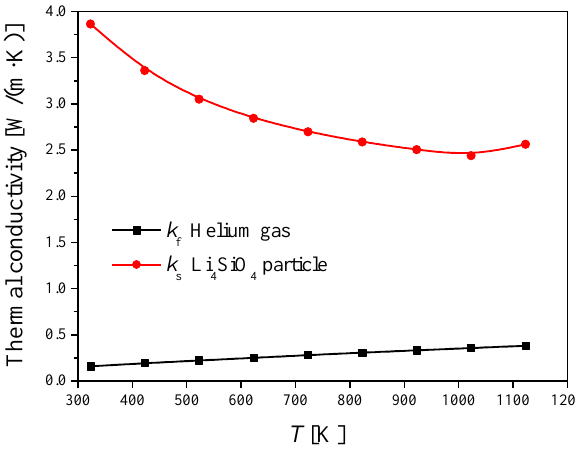
Figure 3. Variations of thermal conductivities for Li4SiO4 particles and helium gas.